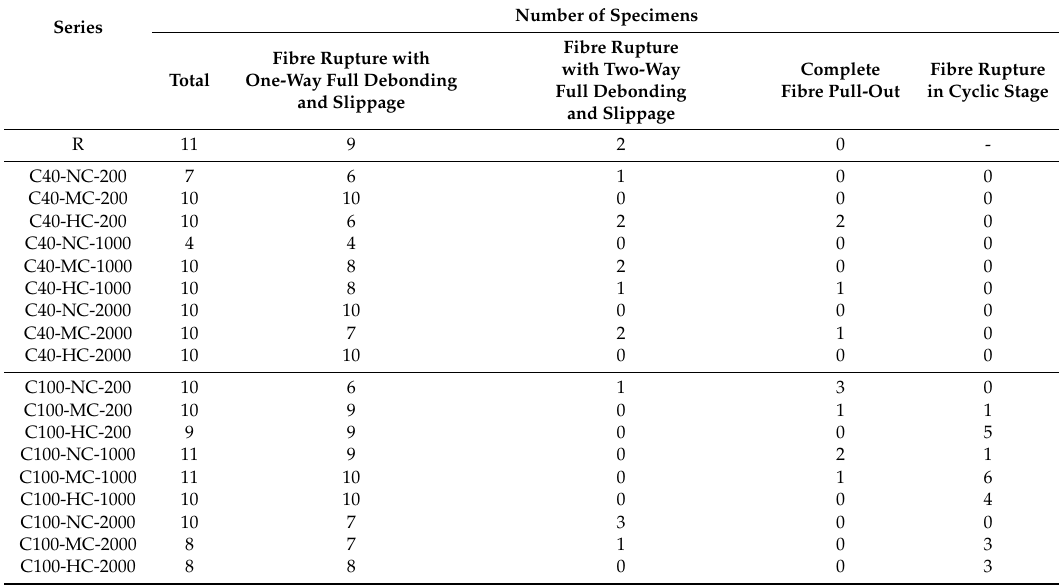
Table 4. Summary of tests to study the influence of the crack width under consideration of the observed crack-bridging behaviour.